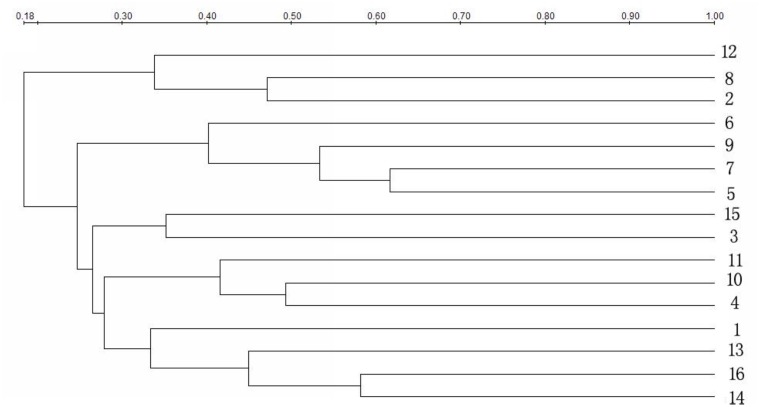
Similarity index of bacterial community in intestines of hens fed in different patterns. Duodenum, jejunum, ileum, and cecum samples from: 30-week-old, free range hens (numbers 1–4); 30-week-old, caged hens (numbers 5–8); 8-week-old, caged chickens (numbers 9–12); 8-week-old, free range chickens (numbers 13–16).